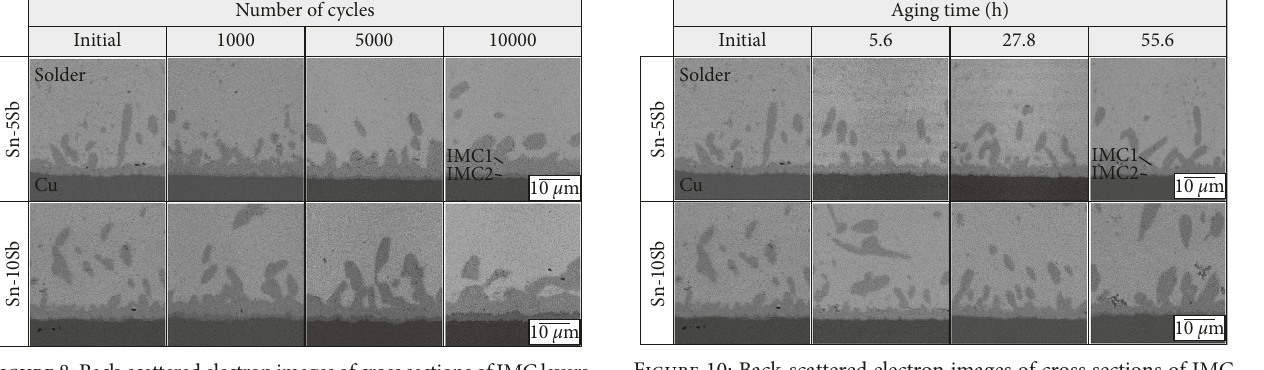
Figure 8: Back-scatteredelectronimagesofcrosssectionsofIMClayers formed in interfaces of Sn-Sb/Cu joints after the power cycling test.